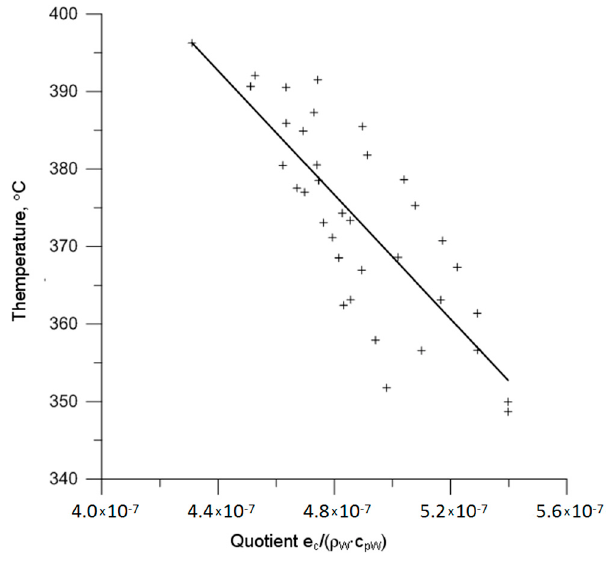
Figure 9. The function graph of changes of the maximum temperature of the chip surface versus the quotient e c /( ρ W ·c pW ).